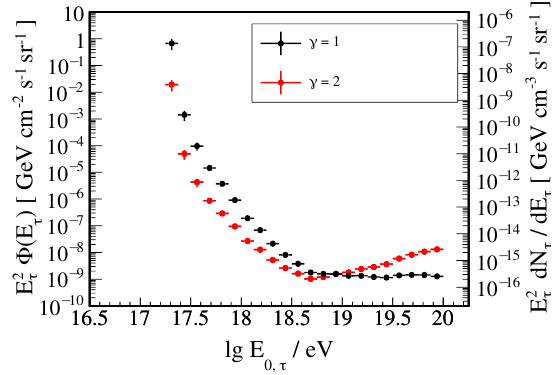
Figure 8. Di ff erential upper limits on the isotropic emergence of τ leptons near the ground at 95% confidence level. The left axis corresponds to the flux of τ -leptons created within 50 km of path length below the Earth’s surface, and the right scale shows the limits on the rate of τ s generated per unit volume, energy, and solid angle. Two indicated spectral indices of the τ flux are